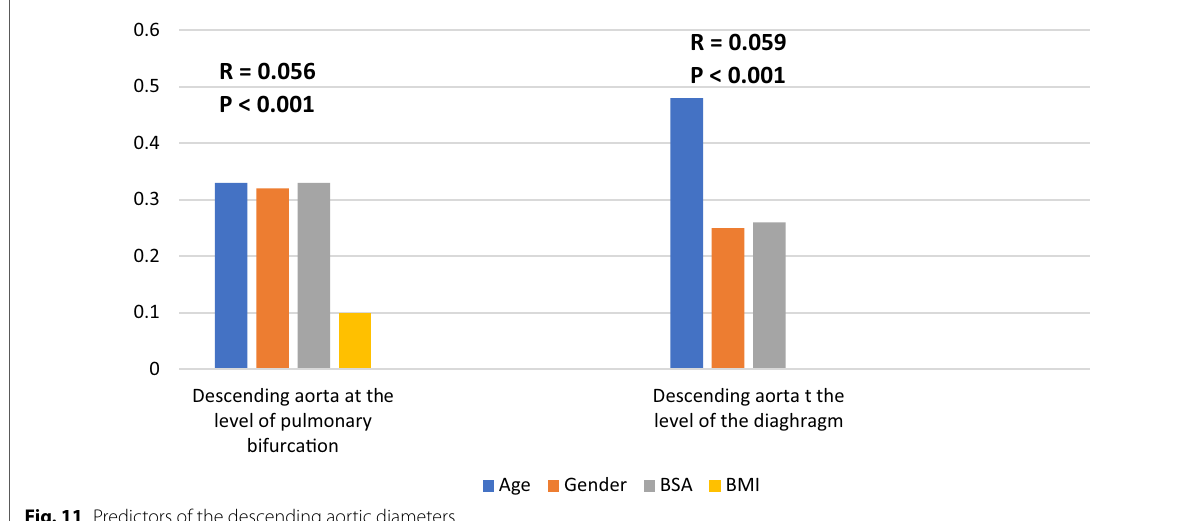
Fig. 11 Predictors of the descending aortic diameters